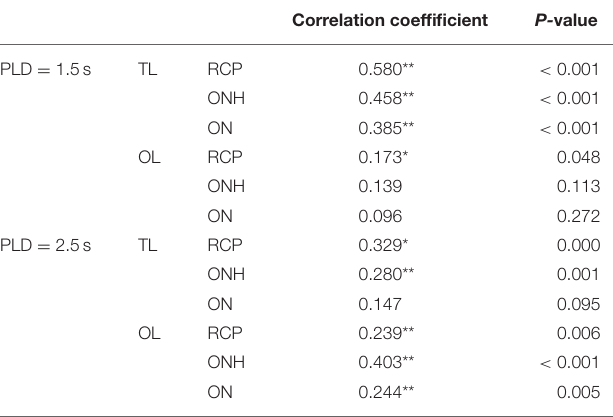
TABLE 3 | Spearman’s rank correlation analysis between ocular and cerebral BF.